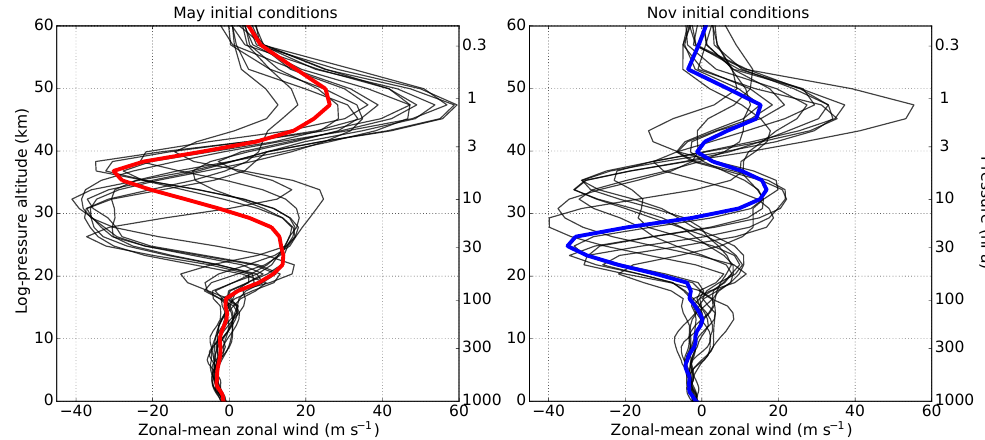
Figure 3. Zonal-mean and daily mean zonal wind (ms − 1 ) profiles at the Equator for 1 May and 1 November for the 15 years 1993–2007 from the ERA-Interim reanalyses (Dee et al., 2011). The two profiles shown in coloured lines (May 1993 and November 2005, taken as representative of eastward and westward QBO phases in the lower stratosphere, respectively) are those used in offline comparison of the gravity wave drag parameterizations presented in Sect. 5.1.